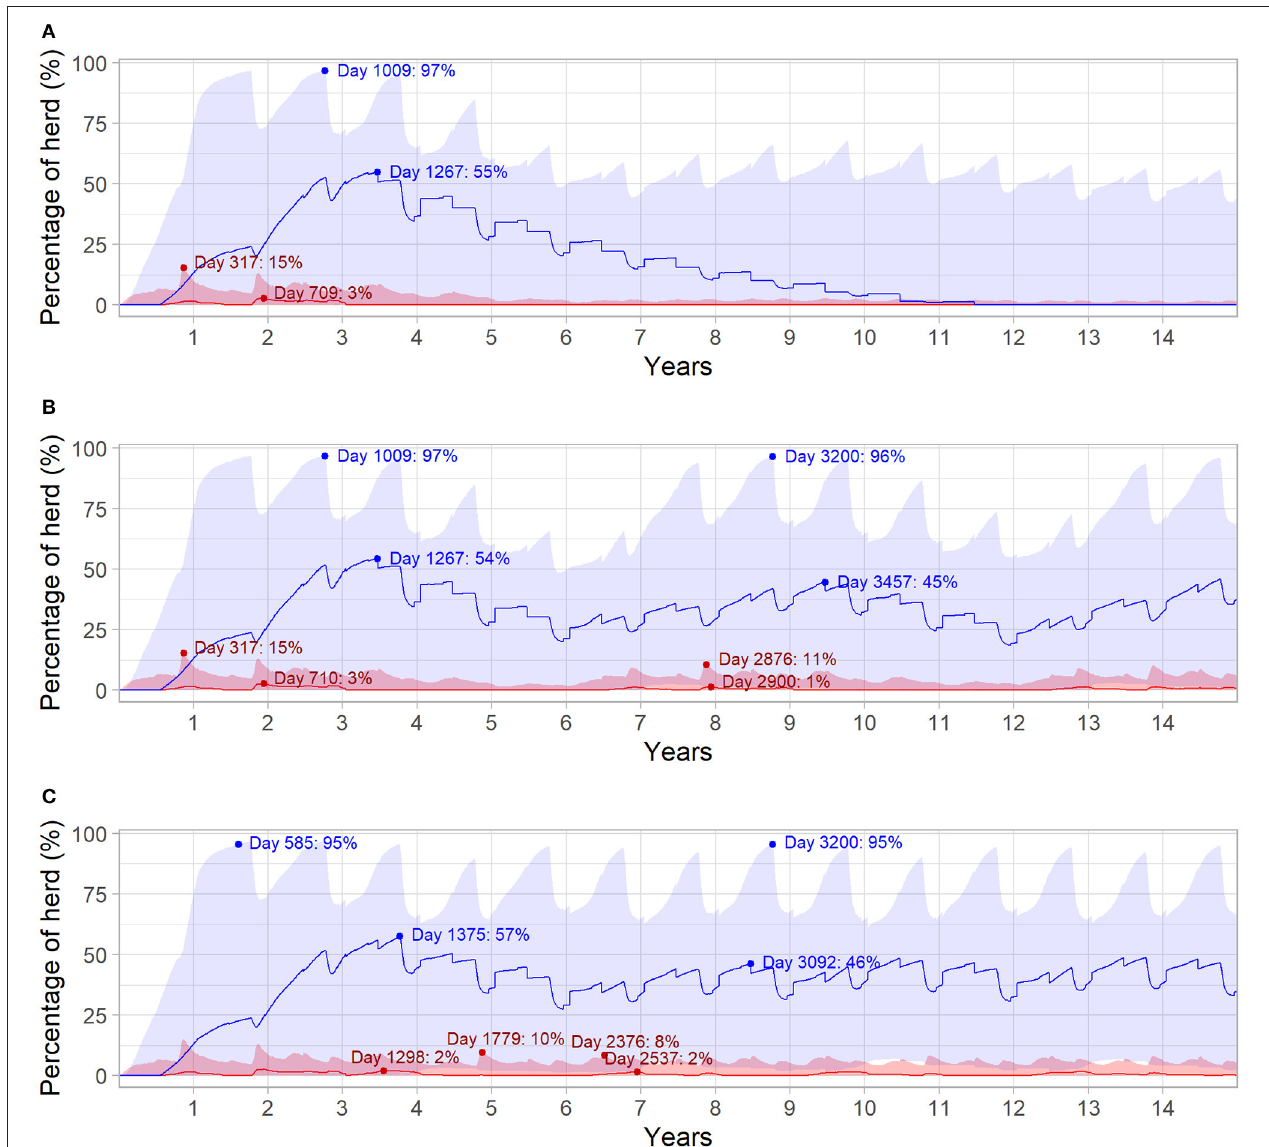
FIGURE 4 | Daily infection dynamics for different BVDV introduction scenarios over 15 years in a simulated beef herd. Introduction of a single PI animal in the first year of the simulation (Scenario 1; A ), introduction of a single PI animal every 6 years (Scenario 2; B ) and introduction of a single PI animal every 3 years (Scenario 3; C ) for 15 years. Percentage of daily viremic (TI and PI) animals (red) and daily seropositive animals (blue), with maternal immunity not represented. Solid red and blue lines indicate the median value for viremic and seropositive animals, respectively, while shaded areas represent the 95% range. Dot points and annotations represent the highest median values following each introduction of a PI animal (values following initial PI introduction in Scenario 3 are removed for improved readability).